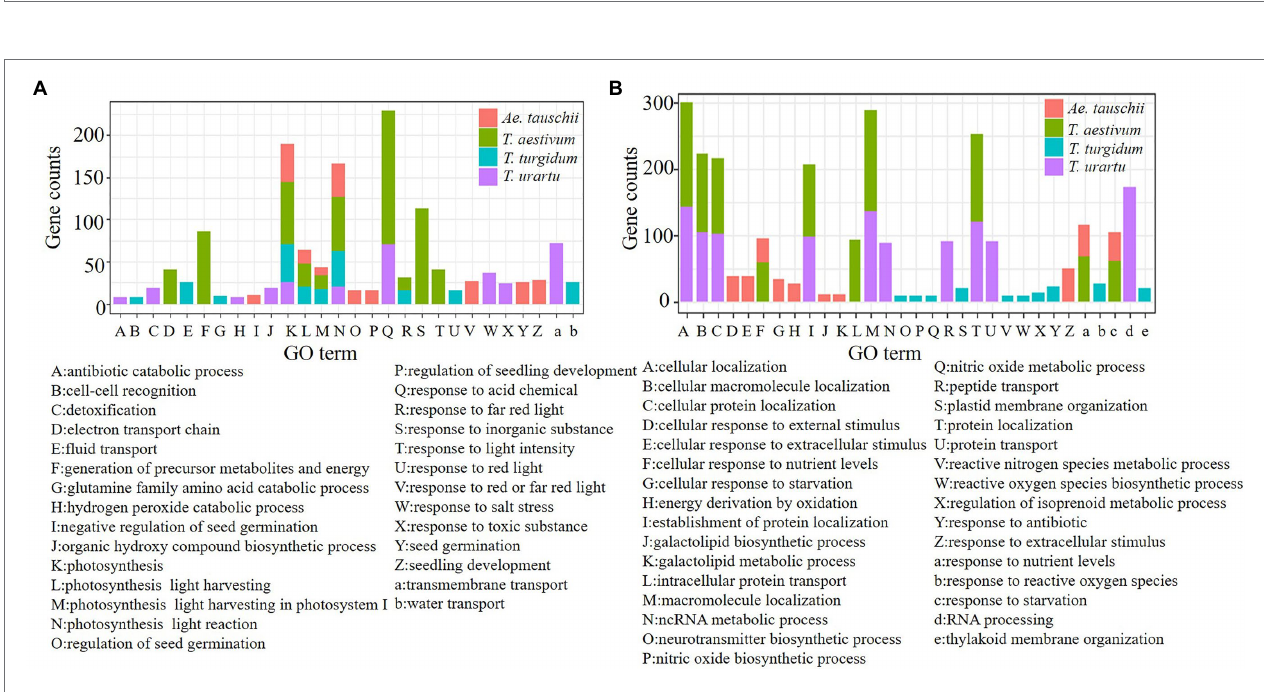
FIGURE 6 | GO enrichment of genes with GC3s (A) and AT3s (B) biased codons from four